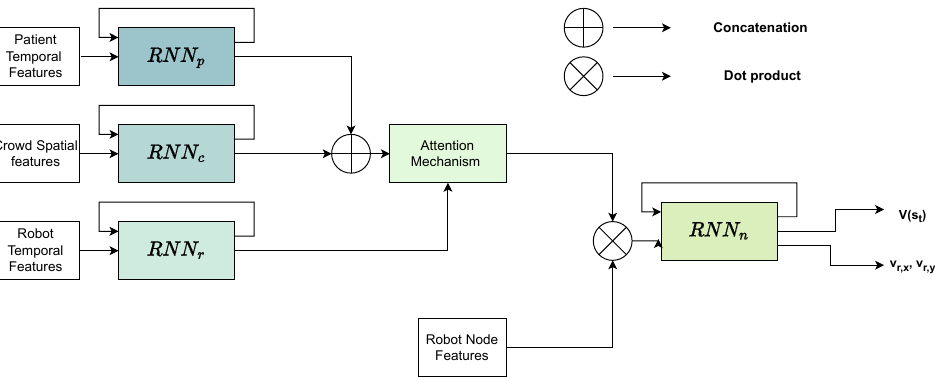
Figure 4. Proposed framework for the patient–robot co-navigation in environments with dynamic obstacles (Model